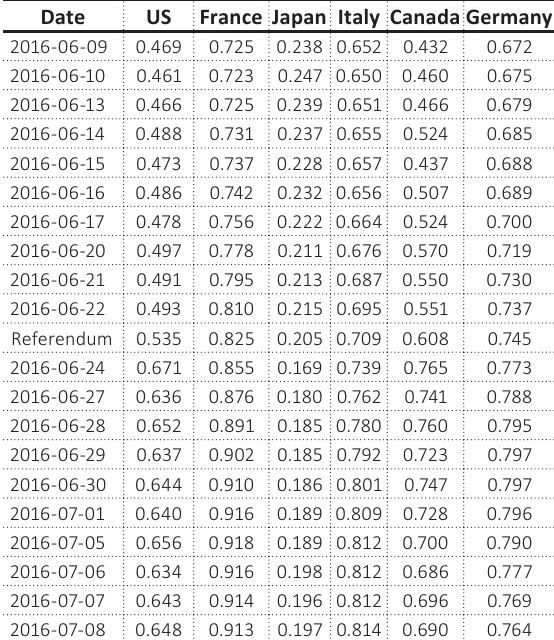
Table 4. Dependence structure before and after the Brexit referendum